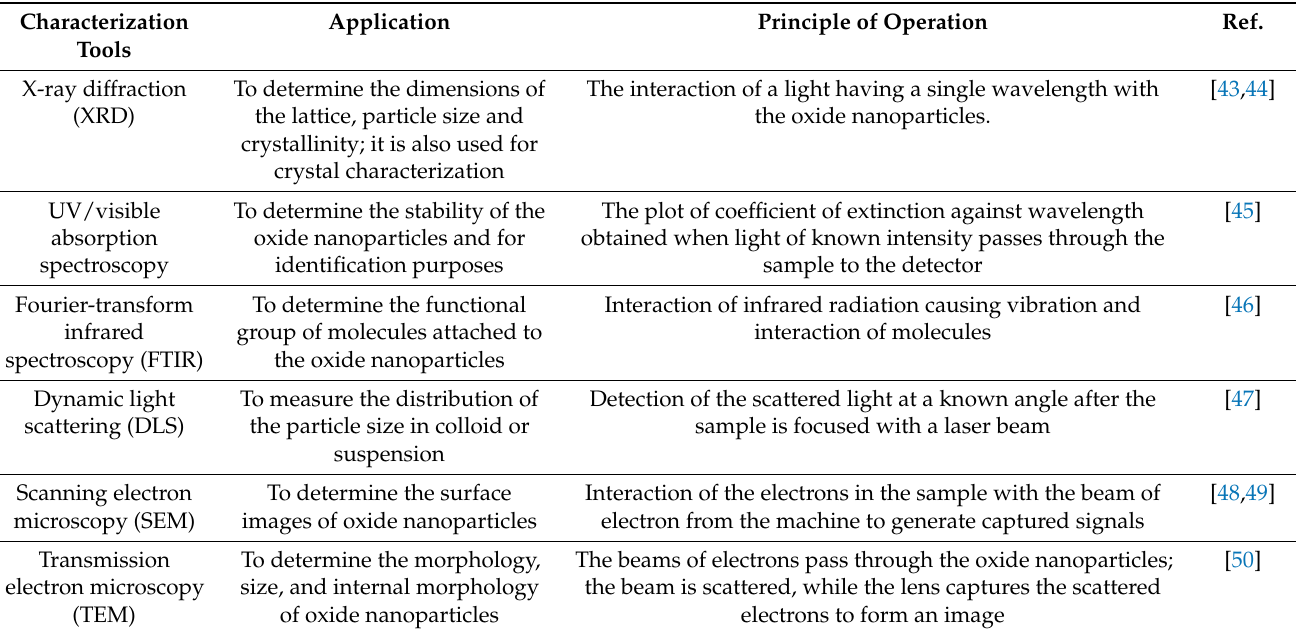
Figure 2. MALDI imaging in soybean cotyledons. ( A ) A cross-section of the cotyledon, exposing the center midway between the tip and the base. ( B ) MALDI-MSI cross-section showing the peak intensity and localization for m / z 3918. ( C ) Cross-section of the cotyledon cut axially from tip to base. ( D ) MALDI-MSI cross-section showing the peak intensity and localization for m / z 5372. Reproduced from [39]; Springer Nature (2011); open access under Creative Commons Agreement. Table 2. Methods of characterizing binary oxide